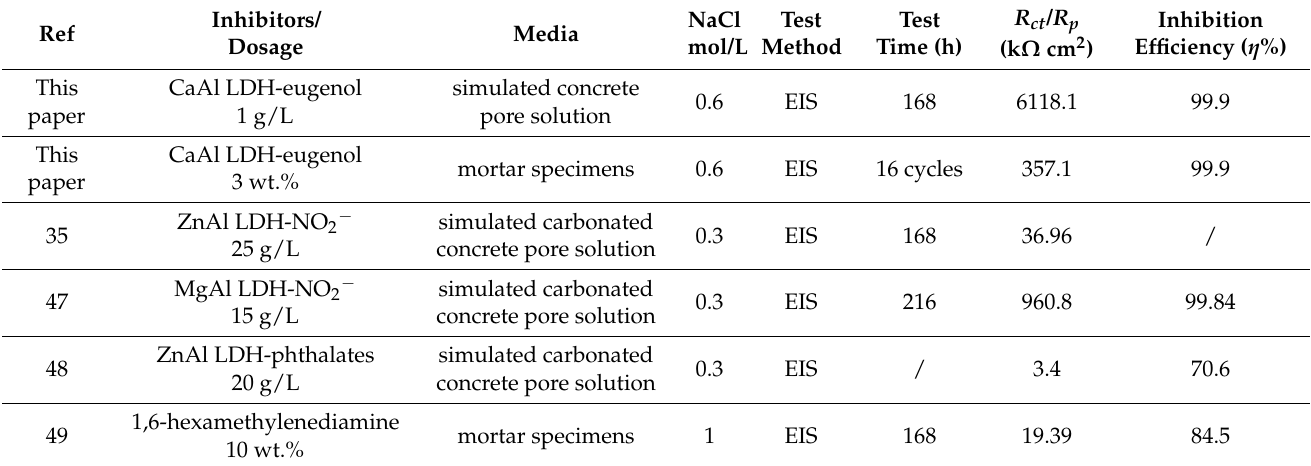
Table 3. The comparative study of corrosion protection effect of LDHs/inhibitors on reinforcing